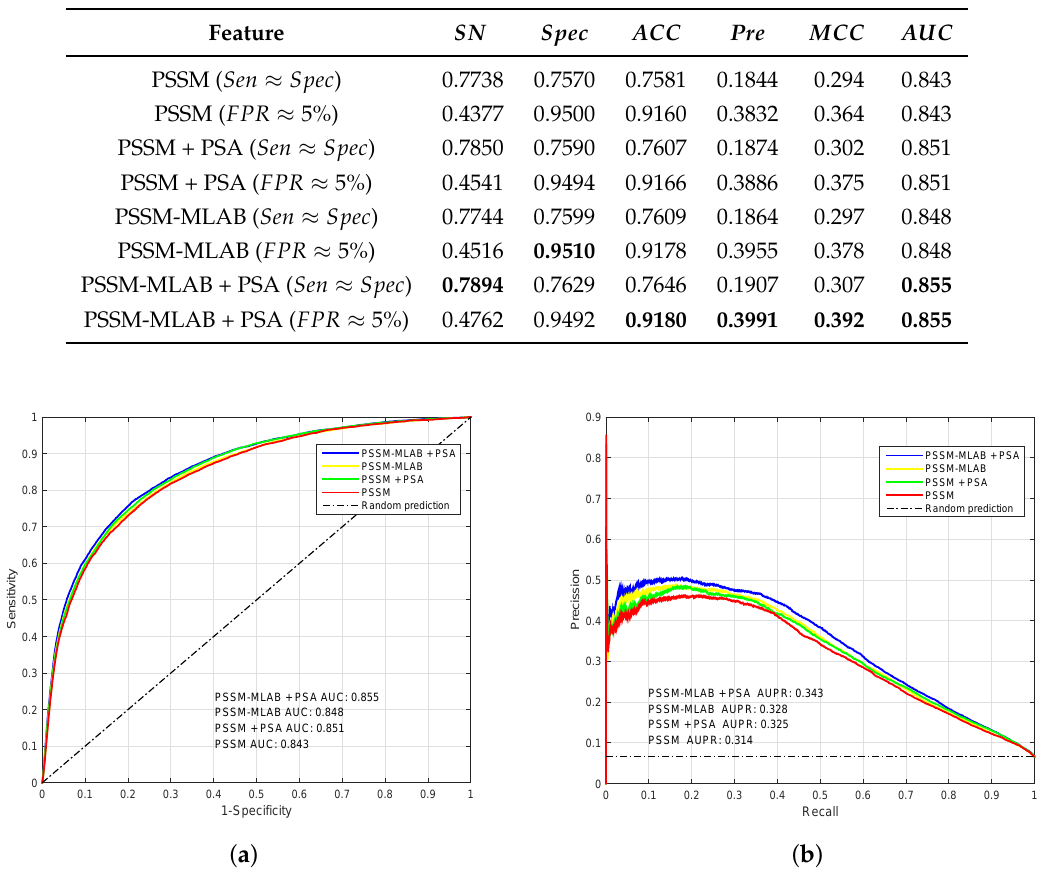
Figure 4. The AUC (Area Under the Receiver Operating Characteristic) and AUPR (Area Under the Precision-Recall curve) of PSSM (Position Specific Scoring Matrix), PSSM + PSA (Predicted Solvent Accessibility), PSSM-MLAB (Multi-scale Local Average Blocks) and PSSM-MLAB + PSA obtained with EC-RUS (Ensemble Classifier with Random Under-Sampling) (WSRC (Weighted Sparse Representation based Classifier), Equation (16)) on PDNA (Protein and DNA)-543 dataset over a ten-fold cross-validation test. ( a ) receiver operating characteristic curves; ( b ) precision–recall